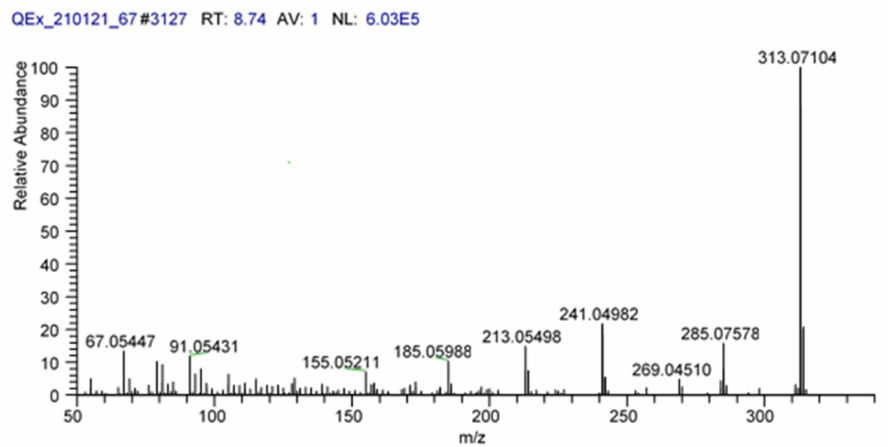
Figure A1. MS/MS Spectrum of AfB 1 , confirmed by reference standard.